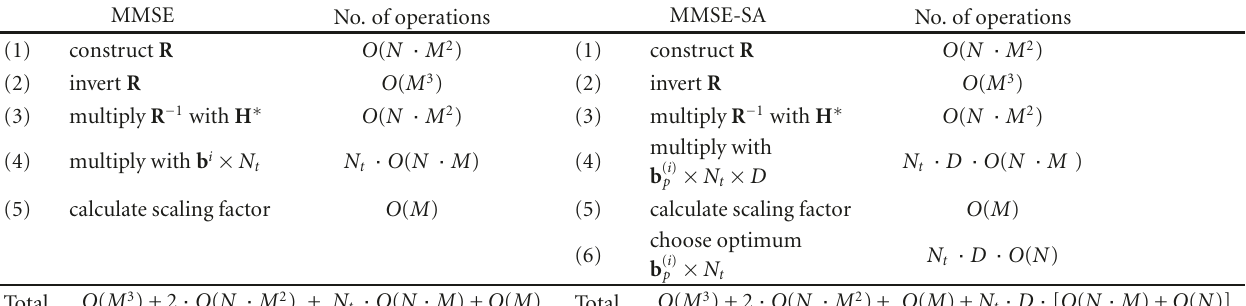
Table 1: Complexity in numbers of operations for MMSE and